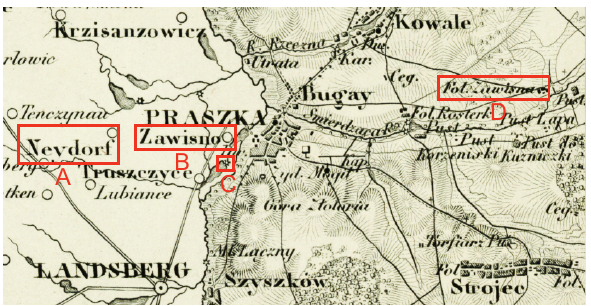
Figure 7. Fragment of the Topographic Card of the Kingdom of Poland with marked objects po- tentially related to Zawisna : ( A ) Neydorf —a settlement (now the village of Nowa Wie´s Oleska ), ( B ) Zawisno —a settlement near the village of Praszka (currently non-existent), ( C ) a mill that lies on the border of the former Kingdom of Poland (currently non-existent), and ( D ) Folwark Zawisna (currently, there are buildings in its